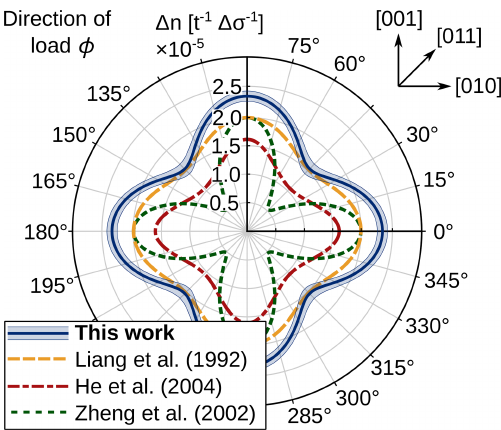
Figure 9. Comparison of the model derived using parameters de- termined in this study to works from the literature. Shear stresses are neglected ( σ 12 = 0).